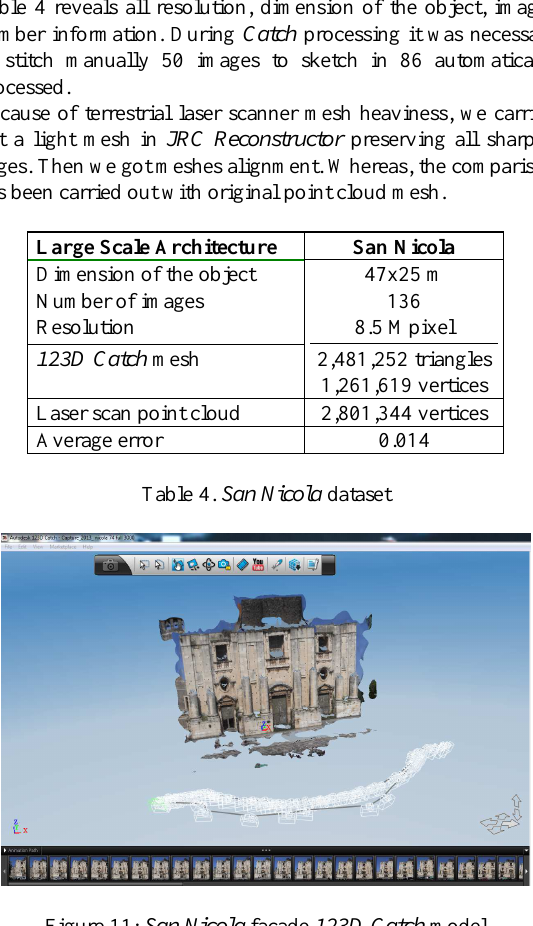
Figure 9: Part of the lateral entrance mesh alignment error visual evaluation histogram: blue (good) red (bad)